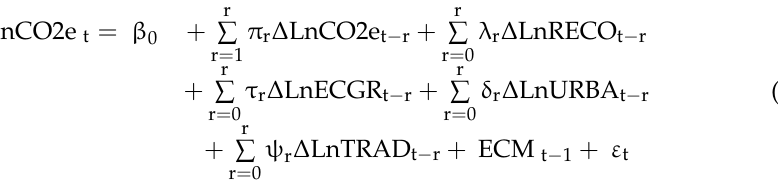
Table 3. Descriptive analysis and variable correlation.